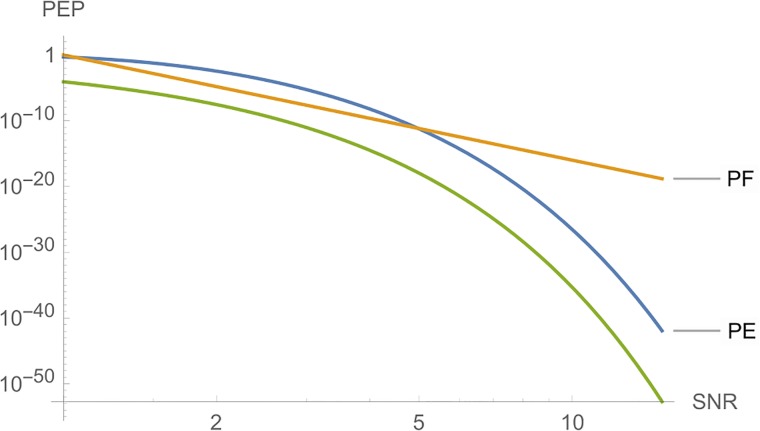
Graphs of PE, PF and PT for Example 3, where nT = nR = l = 4, and SNR is a function of Es.